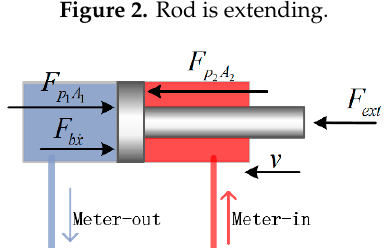
Figure 2. Rod is extending.